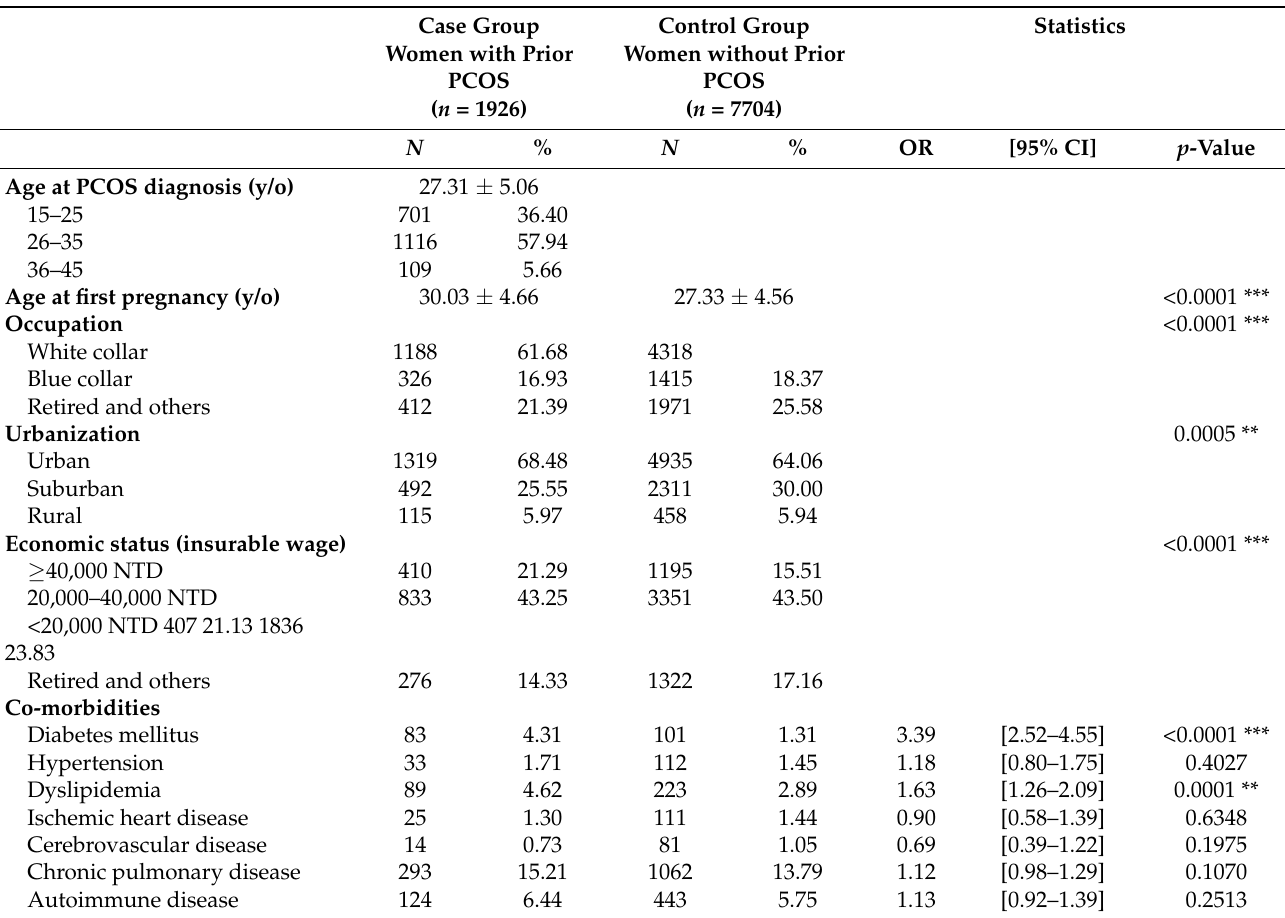
Table 1. The characteristics of pregnant women with and without prior